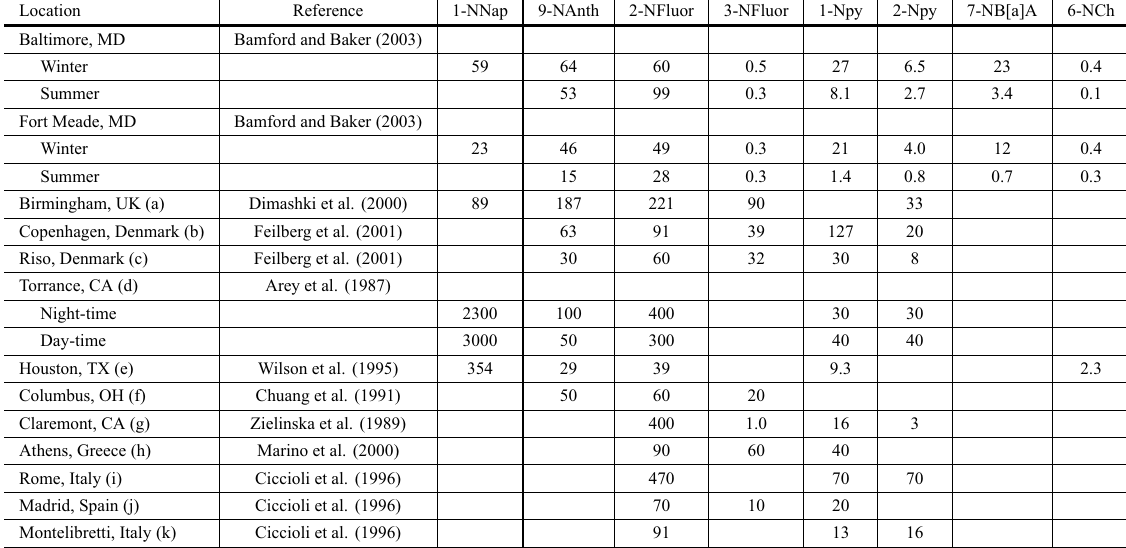
Comparison of atmospheric concentrations of selected nitro-PAH (pg m -3 ) measured in several locations around the world. 1-NNap (1-nitronaphthalene); 9-NAnth (9-nitroanthracene); 2-NFluor (2-nitrofluoranthene); 3-NFluor